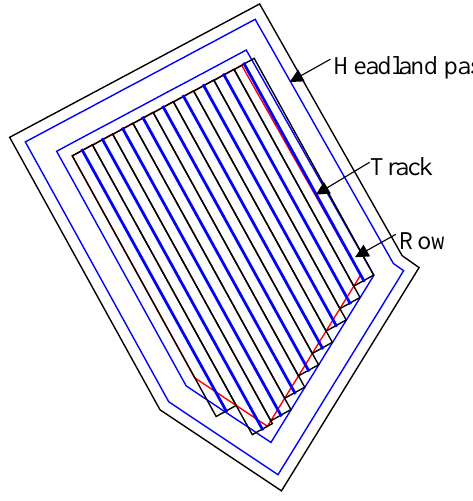
Figure 2. Illustrative example of fixed entities.